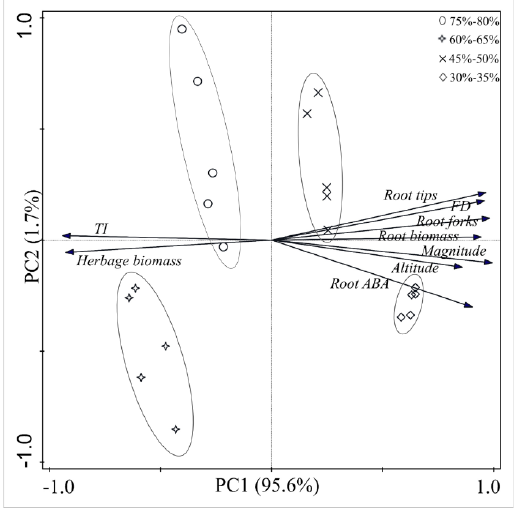
Figure 8. Principal component analysis of alfalfa root system characteristics (with water stress as the main effect) under soil water content treatments (75 – 80%, 60 – 65%, 45 – 50%, and 30 – 35% of water-holding capacity). PC1 accounted for 95.6% of the overall variance and PC2 accounted for 1.7% of the overall variance.